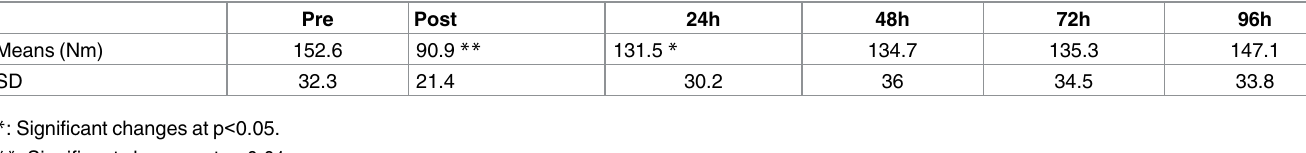
Table 1. Changes in the torque of the ankle joint after the eccentricexercise.